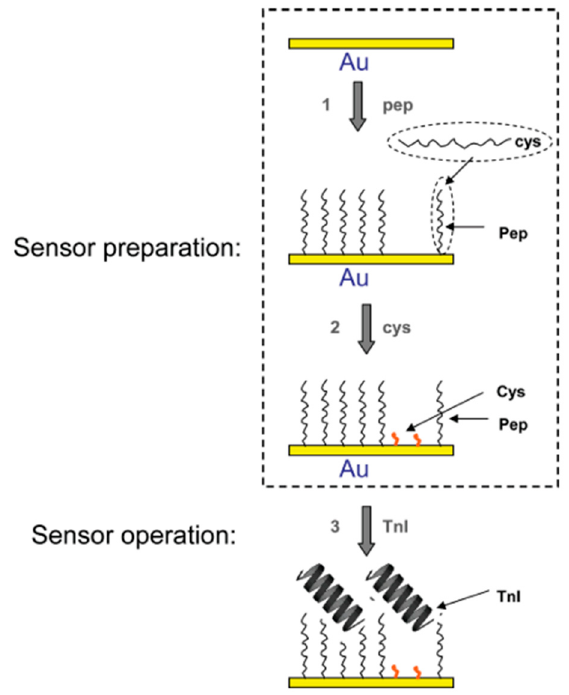
Figure 5. Scheme of peptide-based electrochemical sensor construction basing on a troponin I (TnI) sensor. Subsequent stages include: ( 1 ) the immobilization of cysteine-labeled affinity peptides and ( 2 ) blocking with cysteine. Operation of the sensor consists of incubation with the target’s solution ( 3 ) and electrochemical measurement in the electroactive depolarizer solution. Reprinted with permission from [65]. Copyright 2010 American Chemical Society.